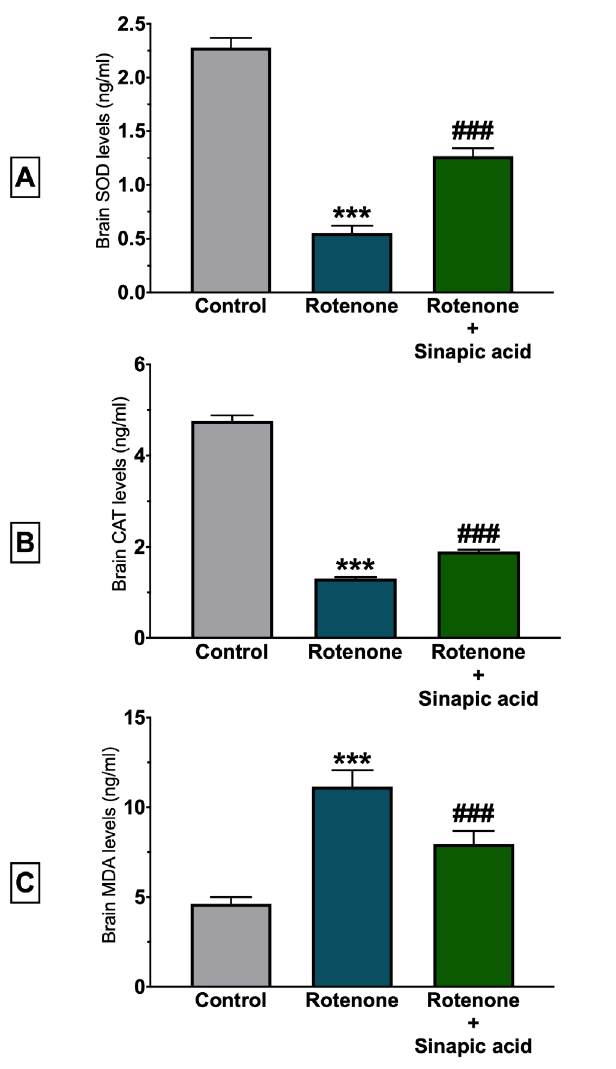
FIGURE 5 - Biochemical analysis of brain SOD (A), CAT (B) and MDA (C) levels in all experimental groups. Rotenone significantly decreased SOD and CAT levels. That decrease was significantly attenuated by sinapic acid. Additionally, rotenone caused lipid peroxidation as expected. Sinapic acid inhibited an increase in lipid peroxidation. All data expressed as mean ± SD. ***p<0.001, ### p<0.001, versus rotenone